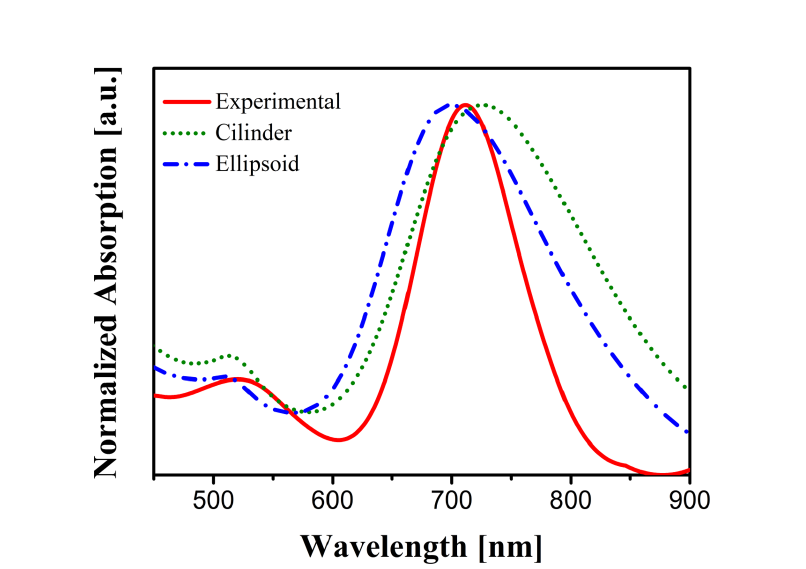
Figure 4. Comparison between experimental and simulatedspectral absorption. The numerical plots are the average of the two main polarizations at θ = 0 o and θ = 90 o